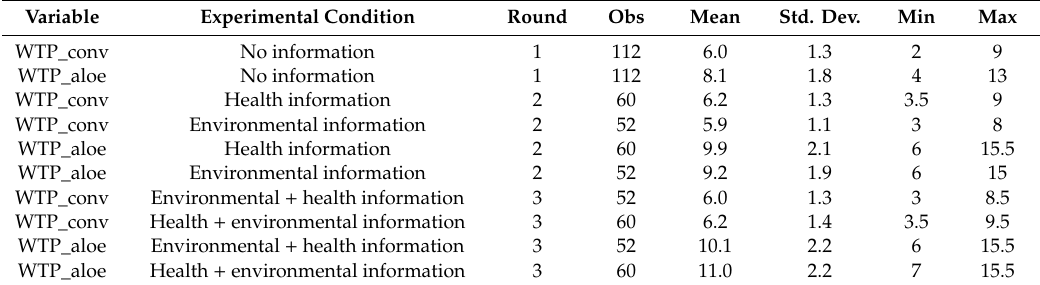
Table 2. Descriptive statistics of elicited willingness to pay for the two compotes in the di ff erent experimental conditions.